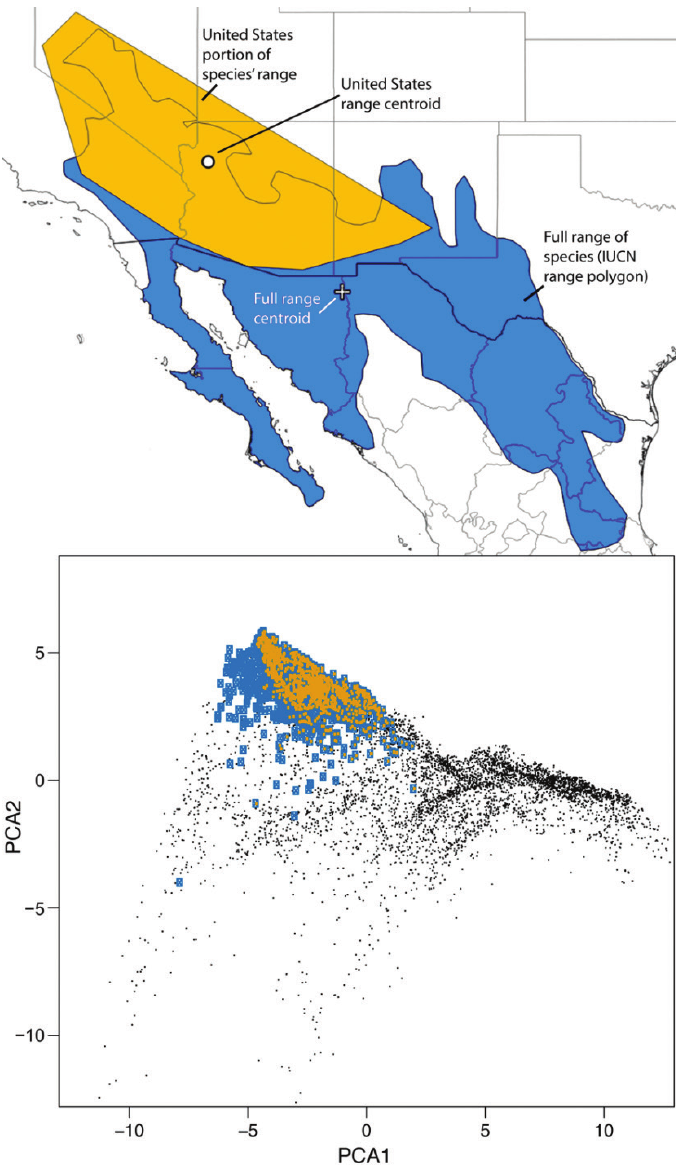
Figure 1. Geographic and environmental spaces for Dipodomys merriami . Top: extent of occurrence polygon for the distribution of D. merriami in the United States (gold, centroid shown by black and white circle), representing the range area analyzed by Dallas et al. (2017), and the full range of the species (blue, centroid show as a cross; polygon from IUCN). Note that the true range centroid falls outside of the convex hull analyzed by Dallas et al. (2017). Bottom: 1799 data points from GBIF (see text) in a space of the first two climatic principal components used by Dallas. et al. (2017; see text). Points in gold are the reduced portion (United States) of the species range analyzed by Dallas et al. (2017); points in blue cover the entire range of the